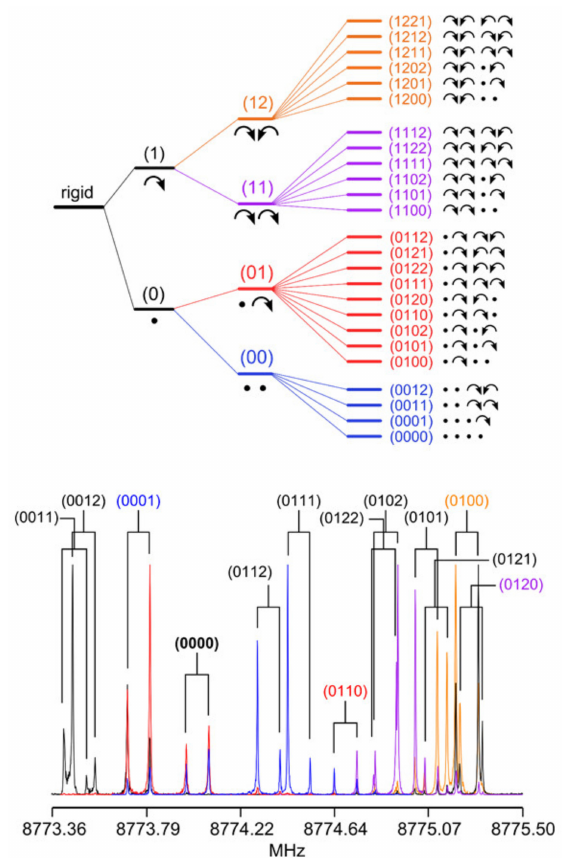
Figure 17. Upper figure: Torsional splittings and spin statistical weights of a rotational transition ( b -type) of 2,3,4,5-tetramethylthiophene. Lower figure: Splittings due to internal rotation of two pairs of equivalent rotors observed in the microwave spectrum of 2,3,4,5-tetramethylthiophene